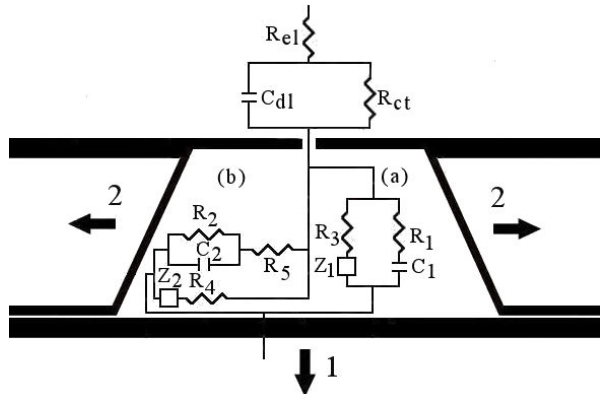
Figure 4. Equivalent electrical circuit for hydrogen diffusion and blocked hydrogen. R el : elec- trolyte resistance, R ct : charge transfer resistance, R dl : double-layer capacitance, R 1,2,5 : adsorption- transfer charge resistances, C 1,2 : adsorption capacitances, R 3,4 : insertion resistances, R 1,2 : diffu- sion impedances, arrows showing the compressive and expansive stress, (1): primary diffusion (reversible potential), (2): secondary diffusion (equilibrium potential) respectively in ( a , b ) for tran- sient impedance.